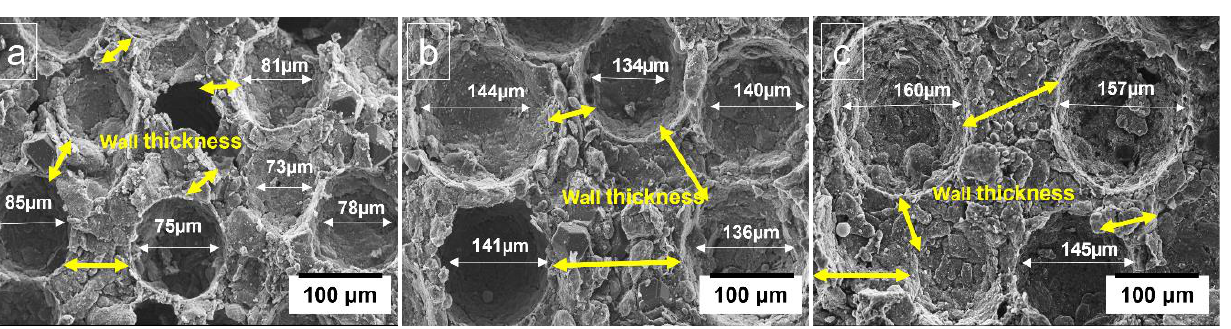
Figure 3. SEM images of ( a ) cell wall, ( b ) diamond particle in the cell wall and ( c ) EDS of material adhered to diamond particle in sintered porous Al composite.